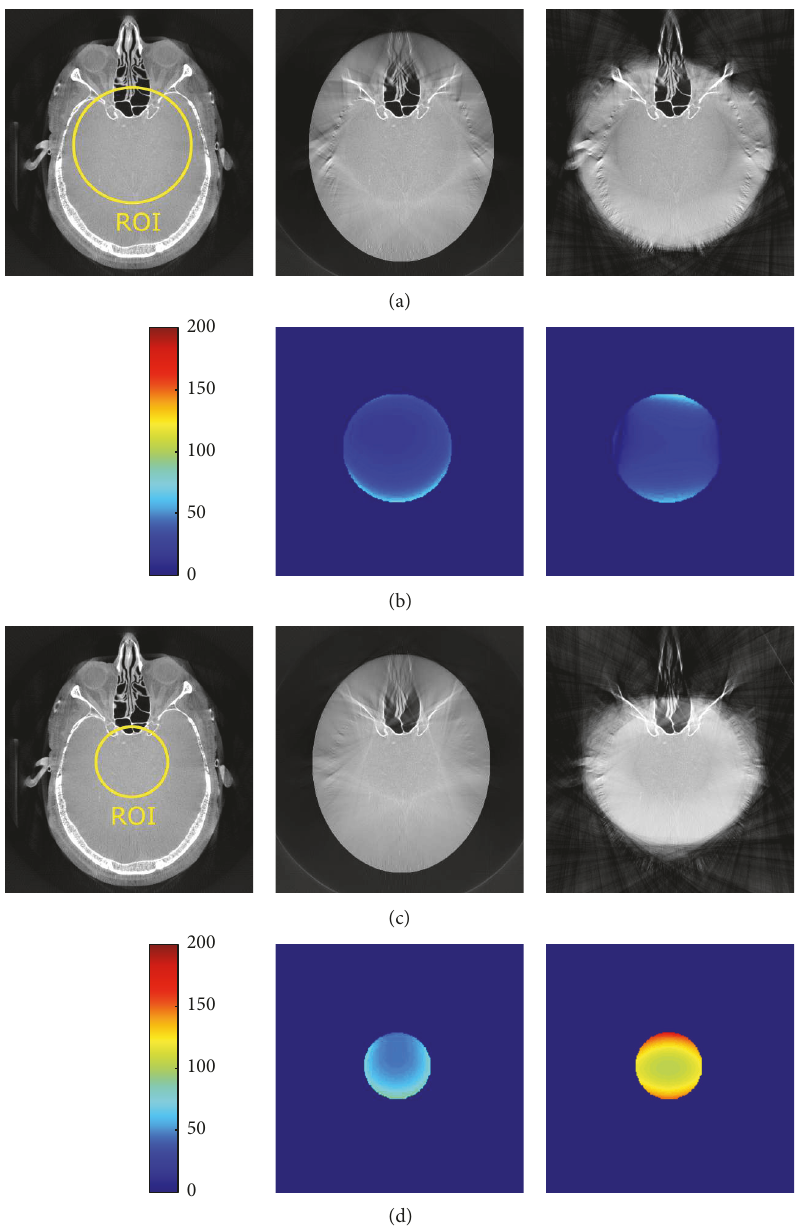
Figure 7: Reconstruction results of the reprojected clinical dataset 2 with both medium truncation (a) and severe truncation (c). (b) and (d) show the corresponding difference images with respect to the reference (only computed in the ROI region). From left to right: reference from nontruncated data, proposed correction method, and water cylinder extrapolation (cf. Berger et al. [8]). The grayscale window: 𝐶 = 0 HU, 𝑊 = 2000